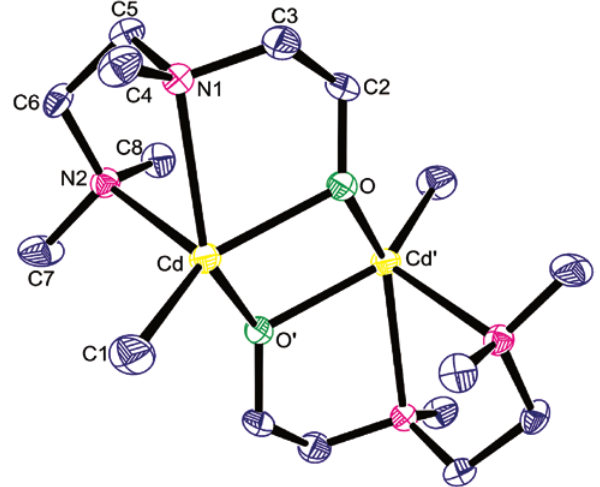
Figure 4: The asymmetric unit of 4 showing the labelling scheme used; thermal ellipsoids are at the 50% probability level.